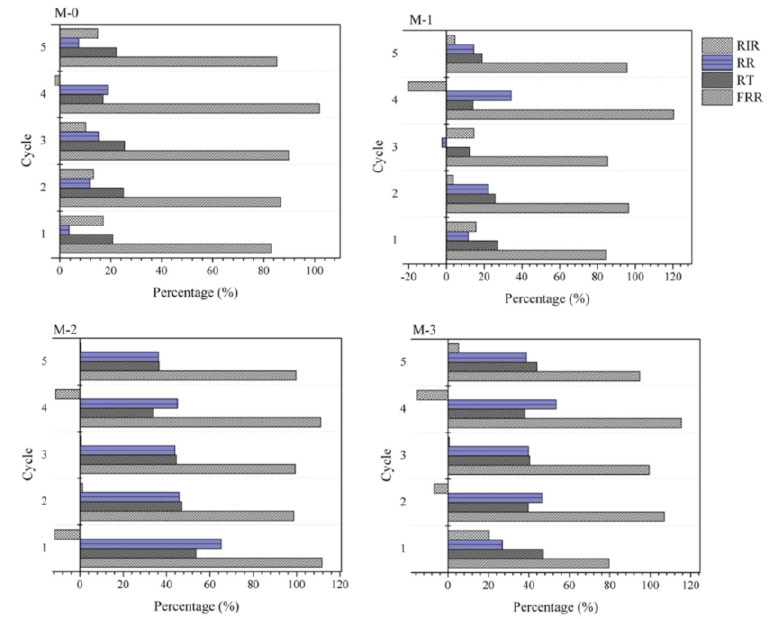
Figure 8. Antifouling parameter of each